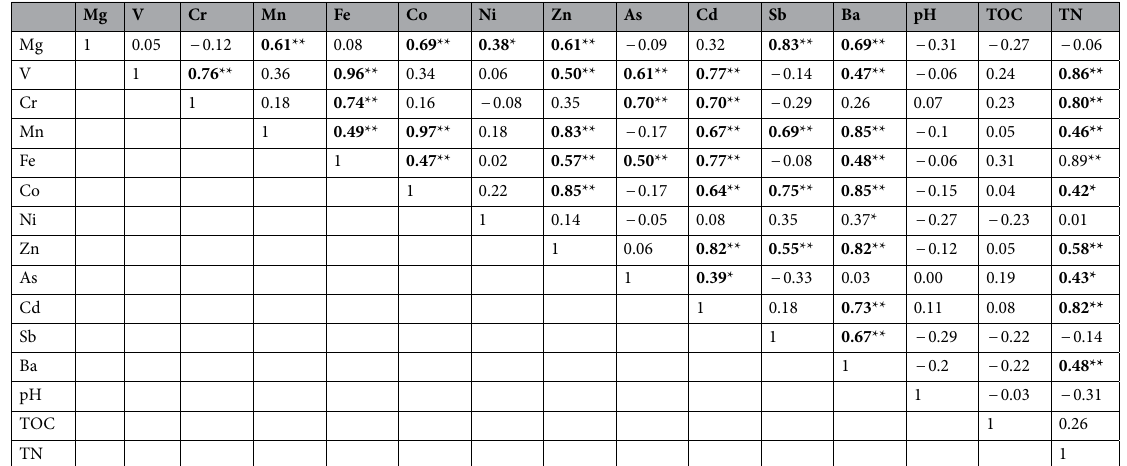
Table 2. Pearson correlation coefficient ( r ) among metals in the surface water of the Xiangjiang River and the physiochemical parameters of the river. Statistically significant values are shown in bold. **Extremely significant correlation, p < 0.01 (2-tailed). *Significant correlation, p < 0.05